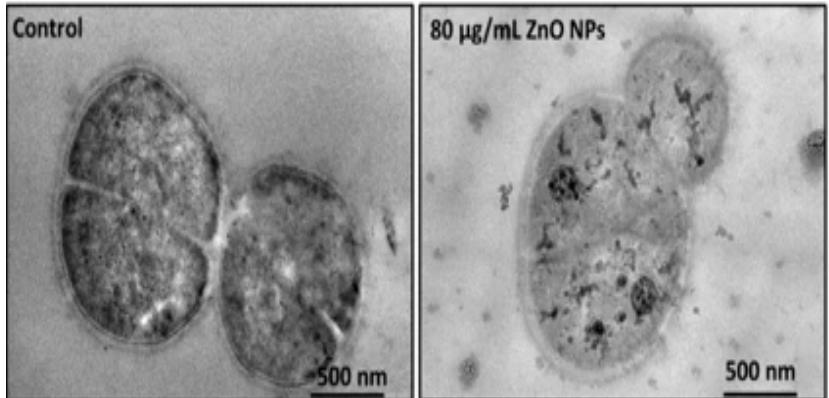
Figure 23. TEM images showing bare D. radiodurans cells (left panel), and internalization of ZnO NPs into bacterial cells (right panel). Reproduced from [276] under a Creative Commons Attribution 4.0 License.